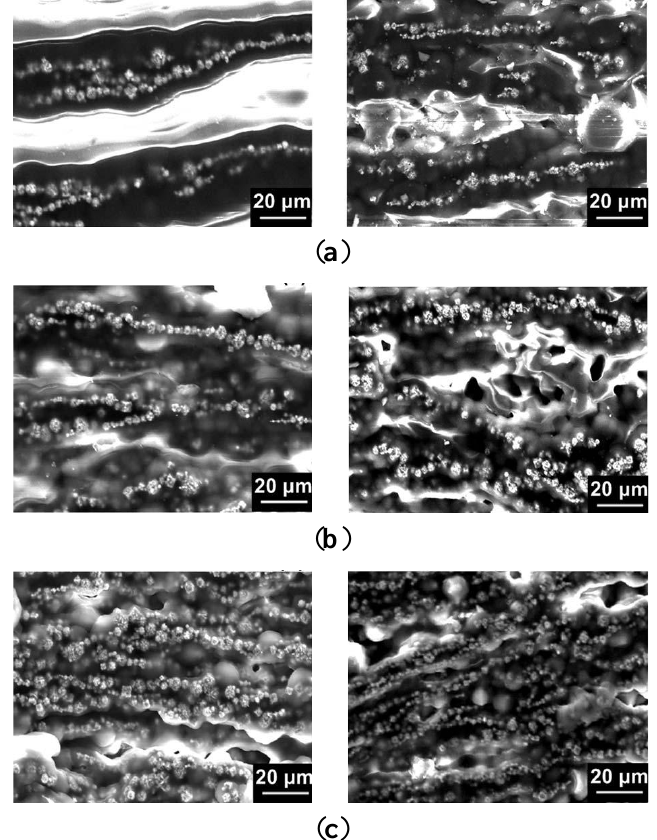
Figure 2. Typical scanning electron microscopy (SEM) images prior to (left column) and after (right column) five stretching-recovery cycles of the Ni chains in three SMP nanocomposites with a different volume fraction of Ni powder: ( a ) 5%; ( b ) 10%; ( c ) 20%. Reproduced with permission from [43]. Copyright 2008 American Institute of